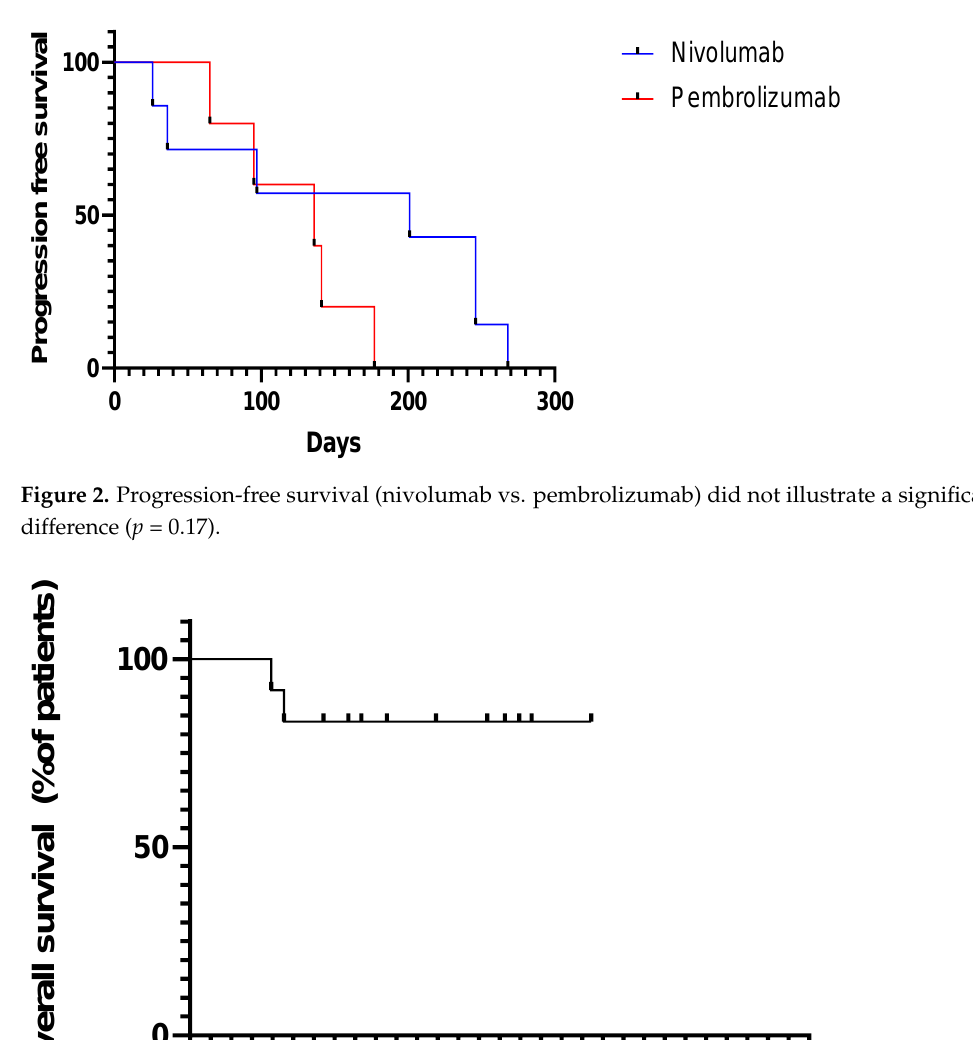
Figure 1. Progression-free survival (all patients).